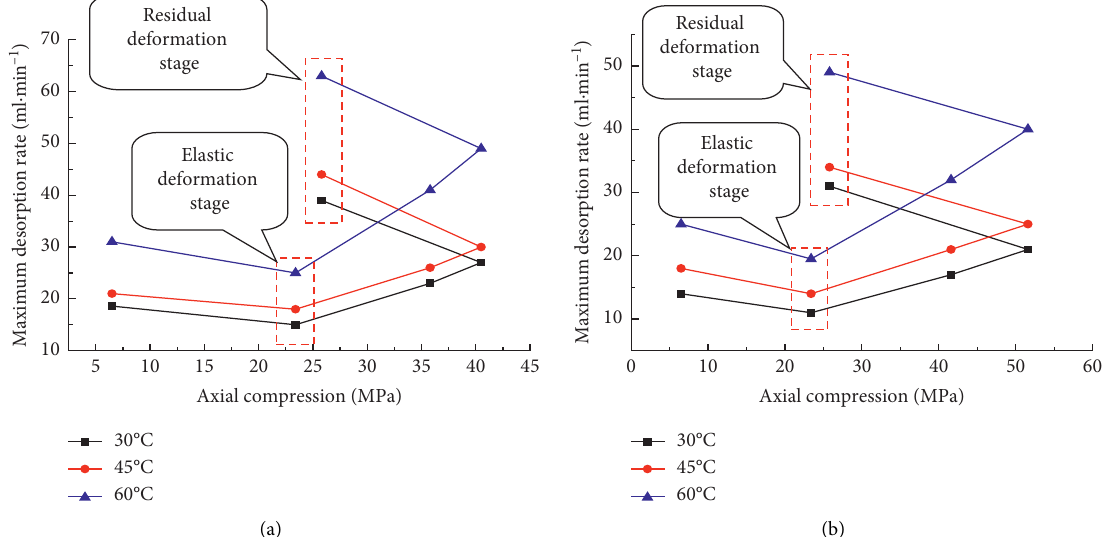
Figure 16: Relation curve between maximum desorption rate and axial pressure under the confining pressure of (a) 3MPa and (b)